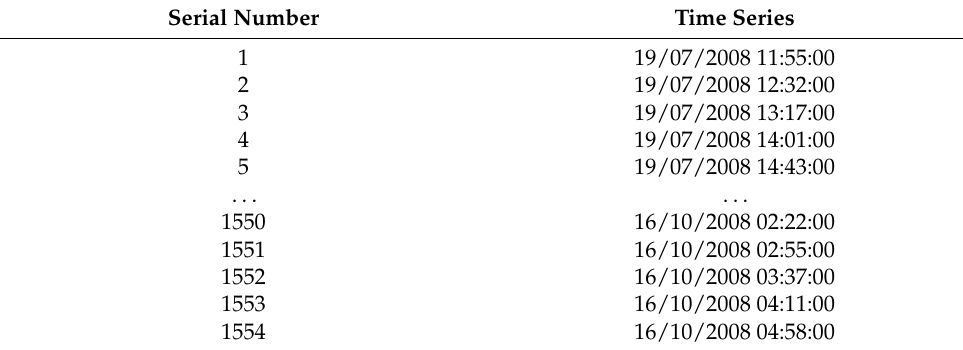
Table 4. Datasets of semiconductor manufacturing